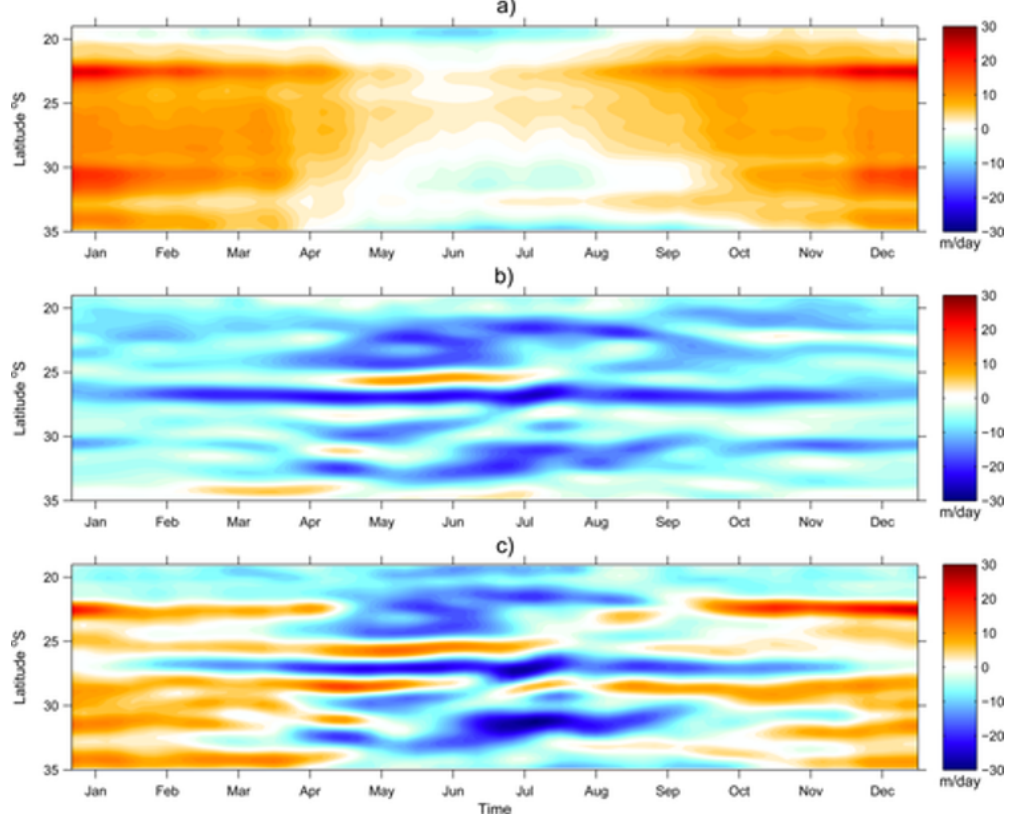
Figure 23. Hovmöller diagrams (latitude versus time) of (a) the Ekman upwelling index (md − 1 , equivalent to vertical velocities), (b) the geostrophic upwelling index (md − 1 , equivalent to vertical velocities), and (c) the composite upwelling index (in md − 1 of vertical velocities, a combination of the two previous components). Red colours represent a balance of forces favouring upwelling events (from Rossi et al.,